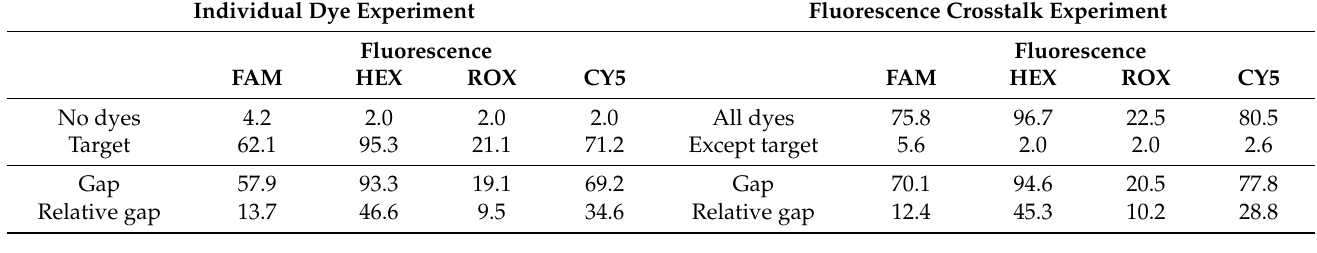
Table 5. Result of individual dye and crosstalk verification experiments in ROI images of Figure 9.